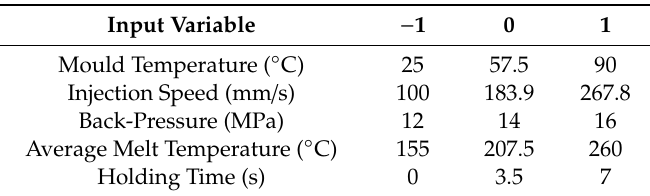
Table 1. 2 5 Full factorial design of experiment